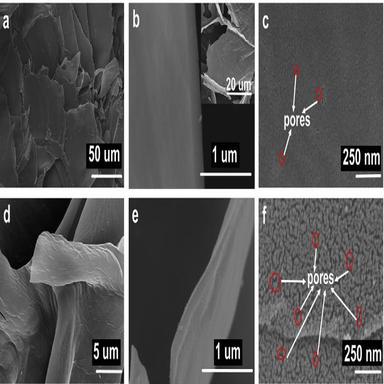
The SEM images of precursor (a), CNS (bec) and CNS-5-1(def). (A colour version of this figure can be viewed online.)